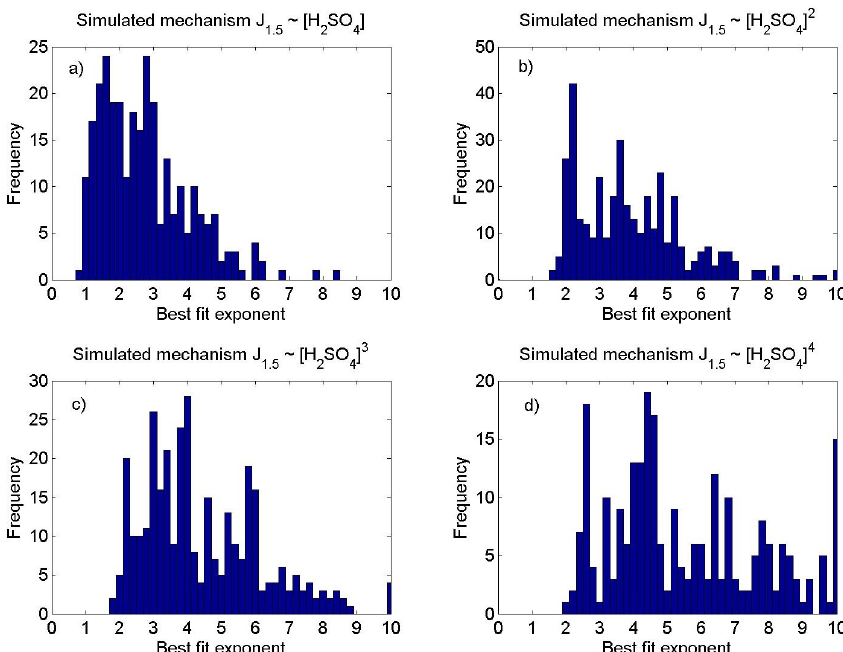
Fig. 4. The frequency distribution of best fit exponents for N 3 − 6 ∼ [H 2 SO 4 ] b for the four nucleation mechanisms: (a) J 1 . 5 ∼ [H 2 SO 4 ] (activation nucleation), (b) J 1 . 5 ∼ [H 2 SO 4 ] 2 (kinetic nucleation), (c) J 1 . 5 ∼ [H 2 SO 4 ] 3 , and (d) J 1 . 5 ∼ [H 2 SO 4 ] 4 . Note that the peaks at exponent 10 are due to the fact that only b = [0.1, 10] was allowed.